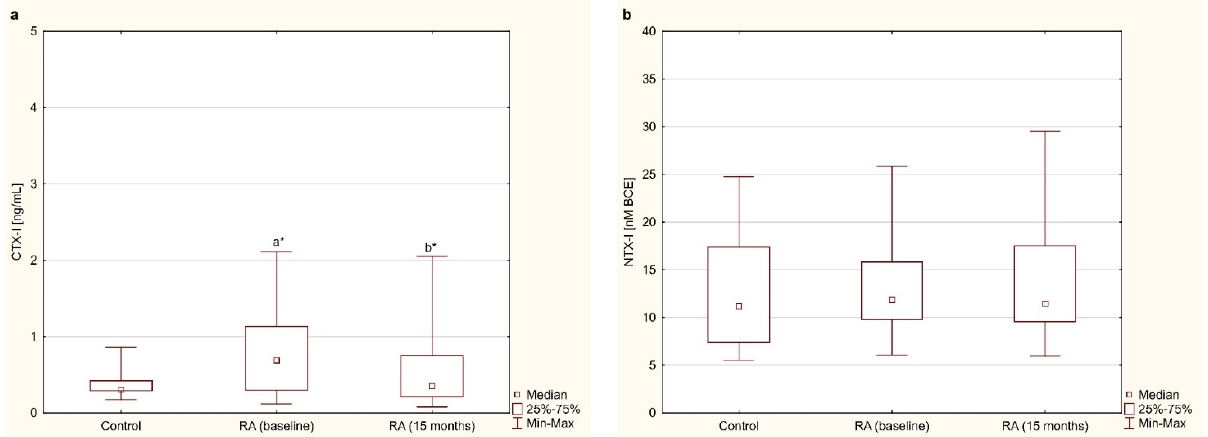
Figure 2. Effect of a 15-month TNF α I therapy on markers of bone resorption: CTX-I ( a ) and NTX-I ( b ) in women with rheumatoid arthritis, and in healthy women. a * p < 0.01 compared to the control; b * p < 0.01 compared to the baseline. CTX-I, C-terminal cross-linking telopeptides of type I collagen; NTX, N-terminal cross-linking telopeptides of type I collagen; RA, rheumatoid arthritis; TNF α I, tumor necrosis factor α inhibitors.